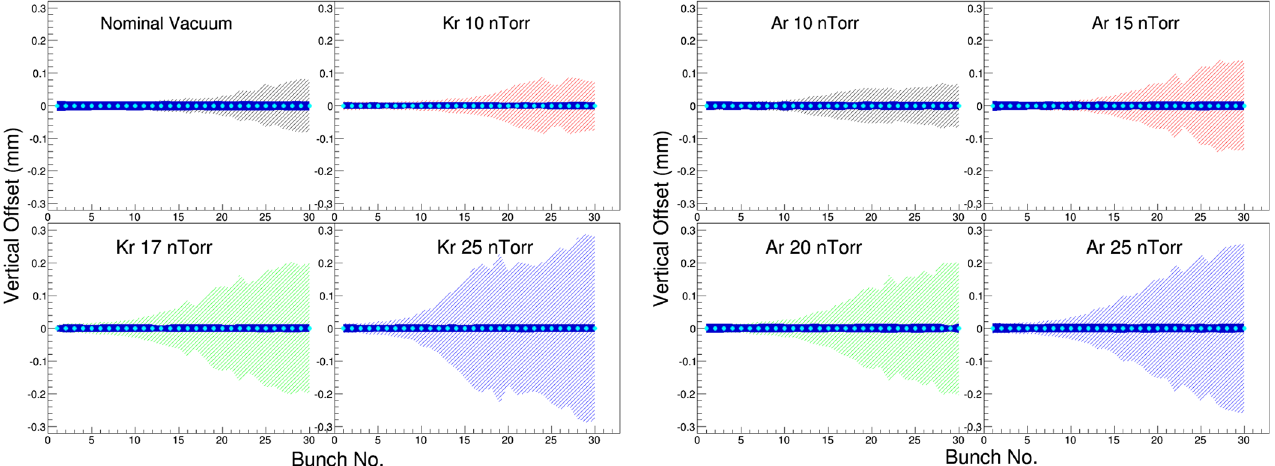
FIG. 1. Vertical bunch motion as a function of bunch number at different pressures (lightly shaded ¼ RMS amplitude with vertical feedback off, filled ¼ feedback on, dots ¼ mean value).